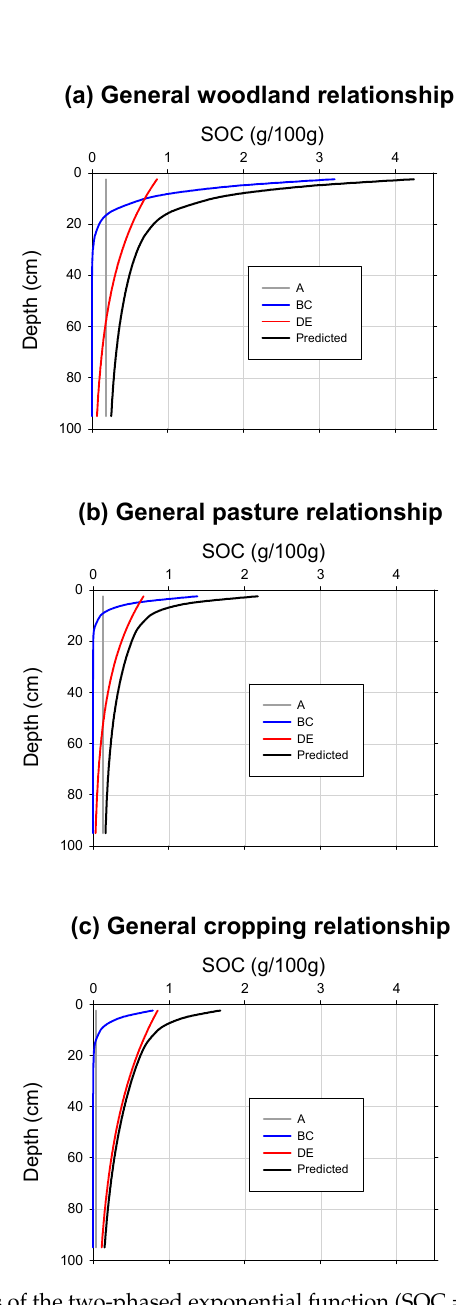
Figure 5. Component parts of the two-phased exponential function (SOC = A + B exp(Cz) + D exp(Ez)) generalised for different land uses ( a ) woodland, ( b ) pasture, ( c ) cropping; fitting parameters are summarised from data for all SOC profiles in Table 3.